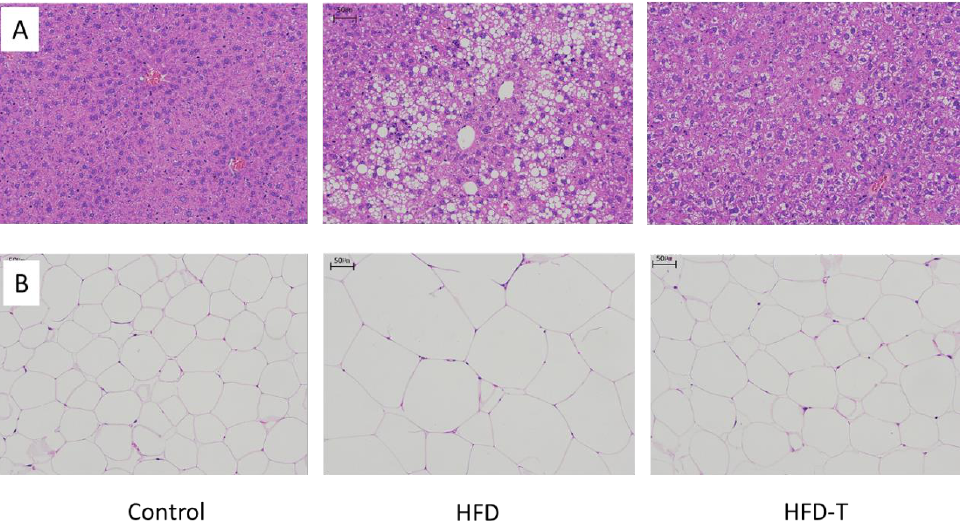
Figure 2. The morphology of liver and adipose tissue after treatment (number of staining = 6/group). Liver sections staining with H&E (scale bar 5 0 μm) ( A ), and white adipose tissue sections staining with H&E (scale bar 5 0 μm) ( B ). Control: normal chow diet, HFD: high fat diet, HFD-T: HFD con-